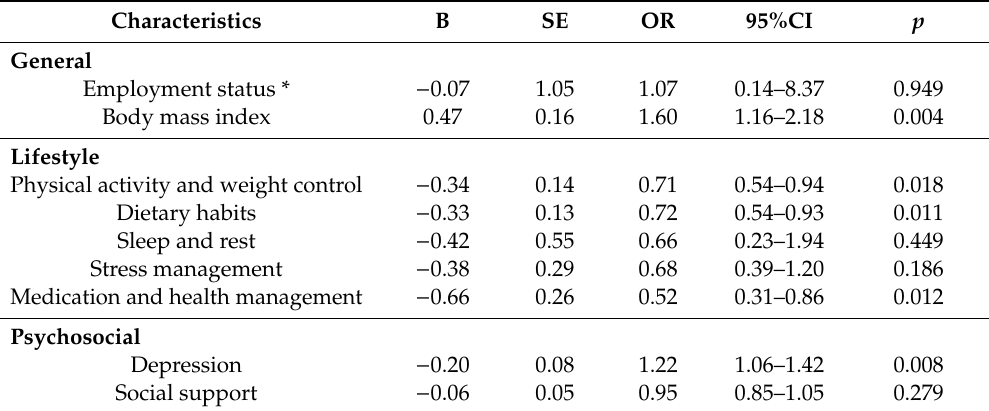
Table 4. Factors influencing metabolic syndrome ( N =